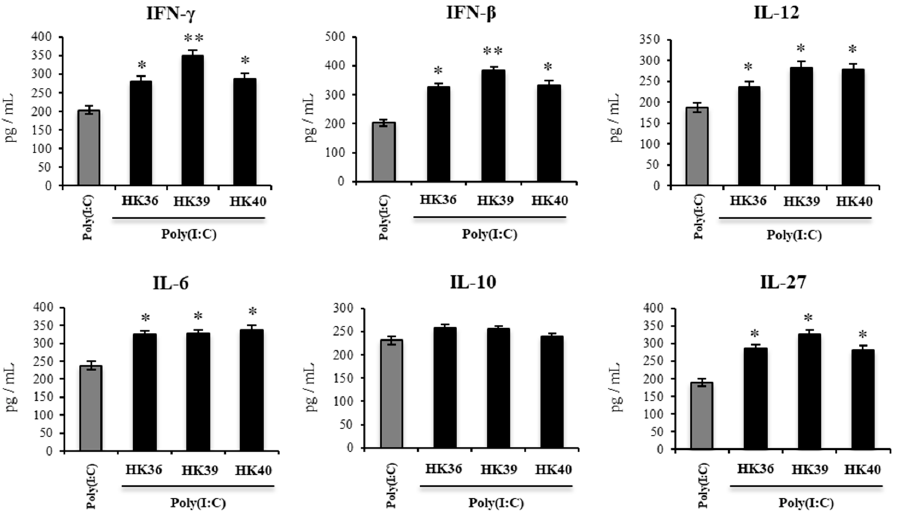
Figure 12. Effect of non-viable Lactobacillus gasseri strains on the immune response induced by the activation of Toll-like receptor 3 (TLR3) in murine alveolar macrophages. Infant mice were nasally primed with non-viable L. gasseri TMT36 (HK36), TMT39 (HK39), or TMT40 (HK40) during two consecutive days. Non-lactobacilli treated mice were used as controls. Broncho-alveolar lavages (BAL) were collected to perform primary cultures of alveolar macrophages of the different groups.